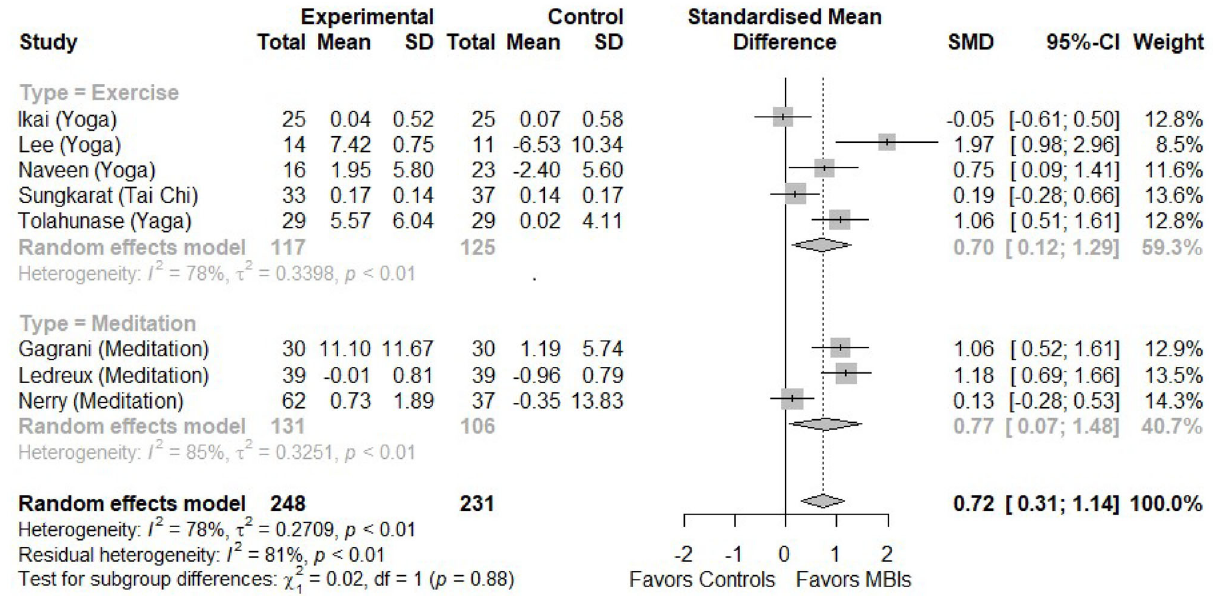
FIGURE 3 | The forest plot of included studies (K = 8).